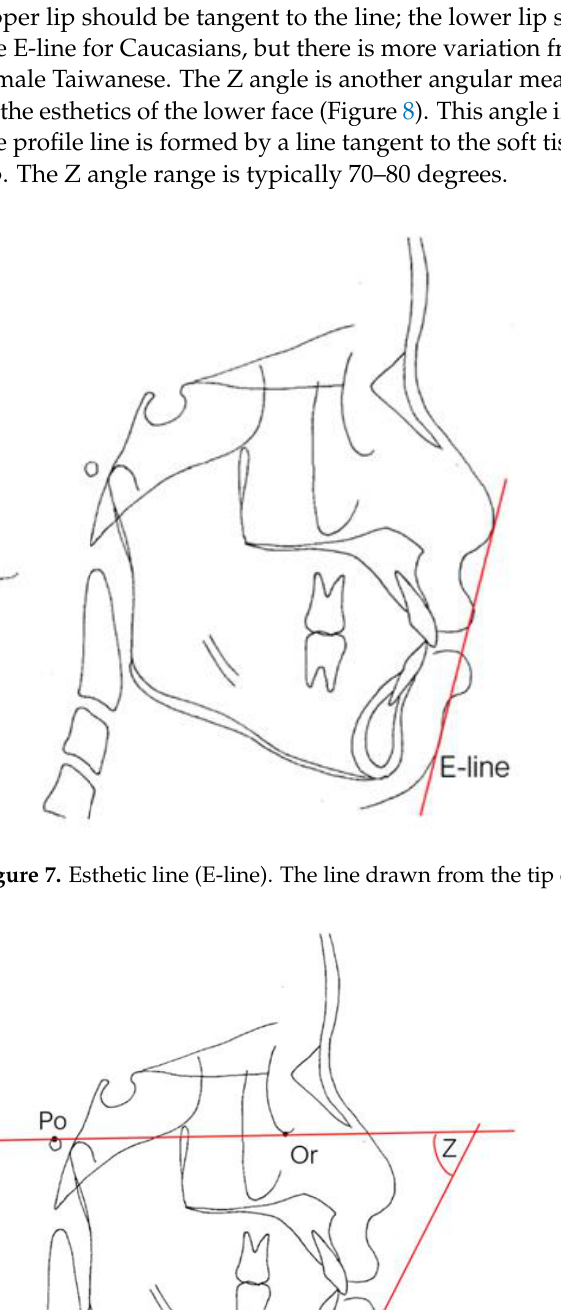
Figure 6. SN plane to the mandibular plane angle (SN–MP). S: sella, the midpoint of the sella tur- cica. N: nasion, the most anterior point of the intersection between the nasal and frontal bones (frontonasal suture). MP: mandibular plane: formed by connecting Go to Me. Go: gonion: the most posterior and inferior point on the angle of the mandible. Me: Menton, the most inferior point on the chin.